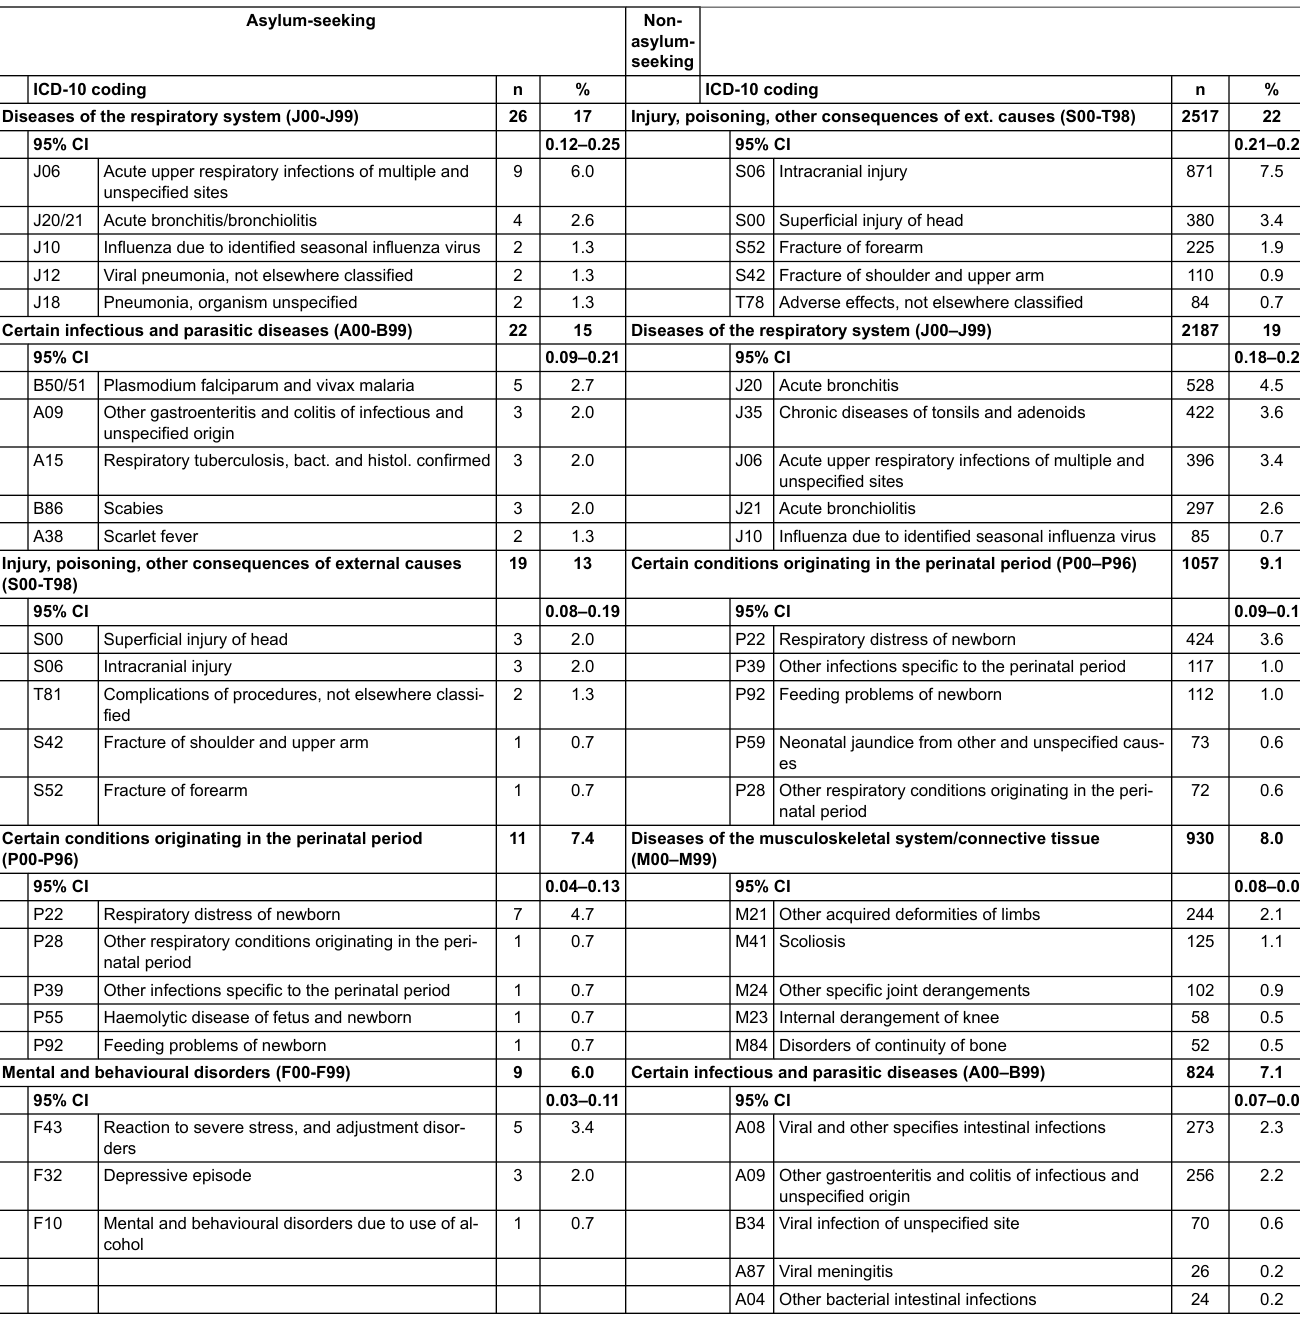
Table 2: Top five of main IC-10 category with top five of main admission diagnosis. 95% CI: Confidence Interval for the proportion of the ICD-10